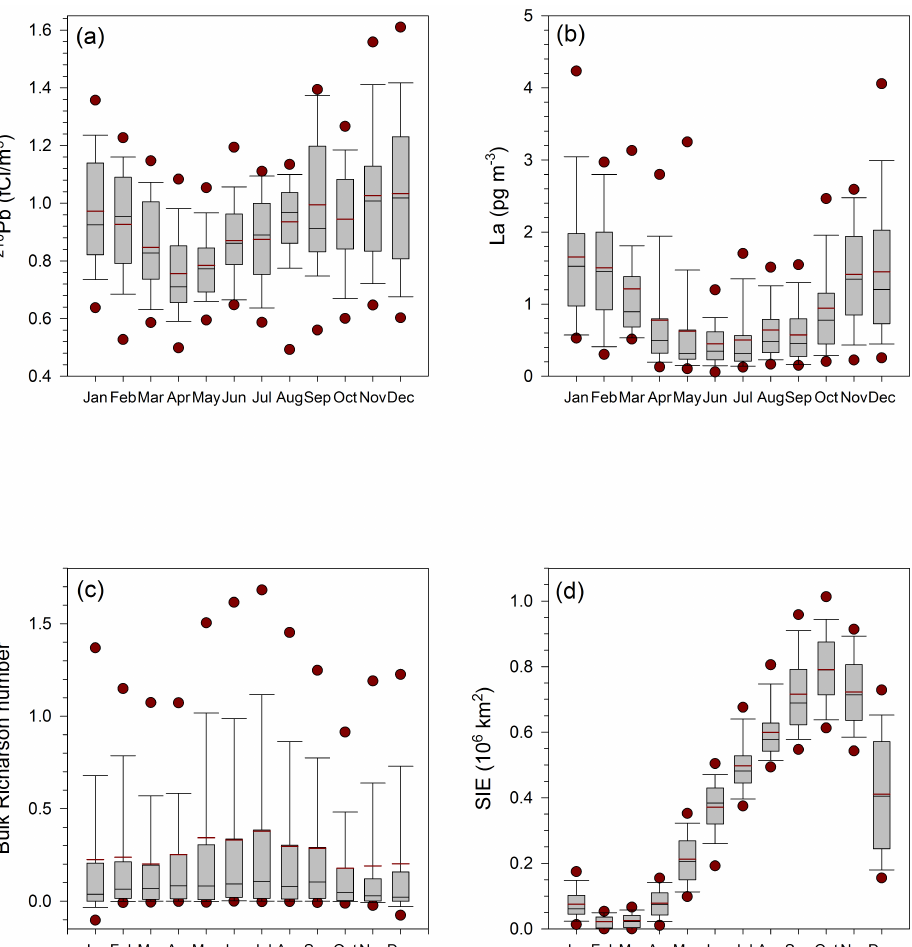
Fig. 10. Box plots for the mean seasonality of (a) 210 Pb concentration, (b) La concentration, (c) bulk Richardson number Ri B and (d) SIE for the sector 20 ◦ –30 ◦ . For description of symbols see Fig.